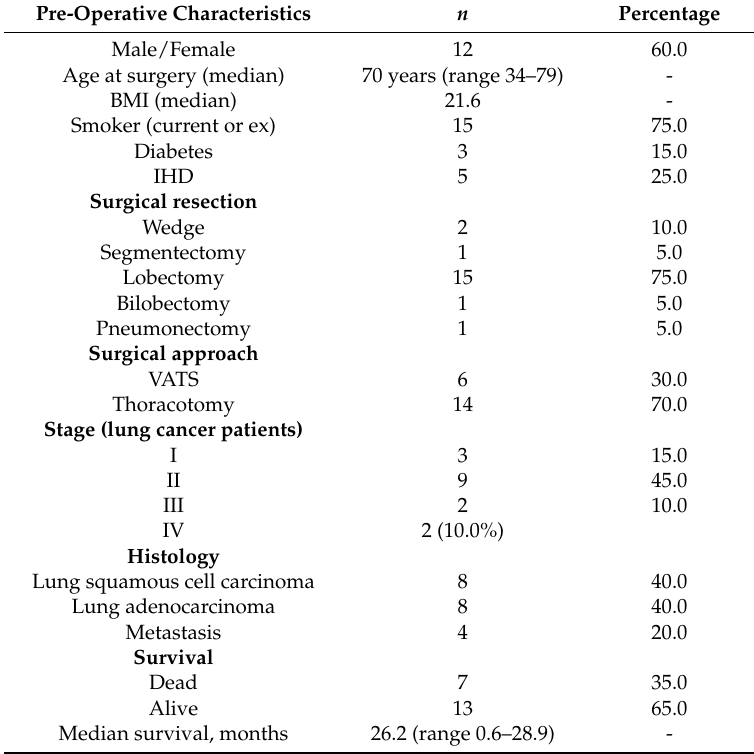
Table 2. LC patient demographics for the Raman spectroscopy